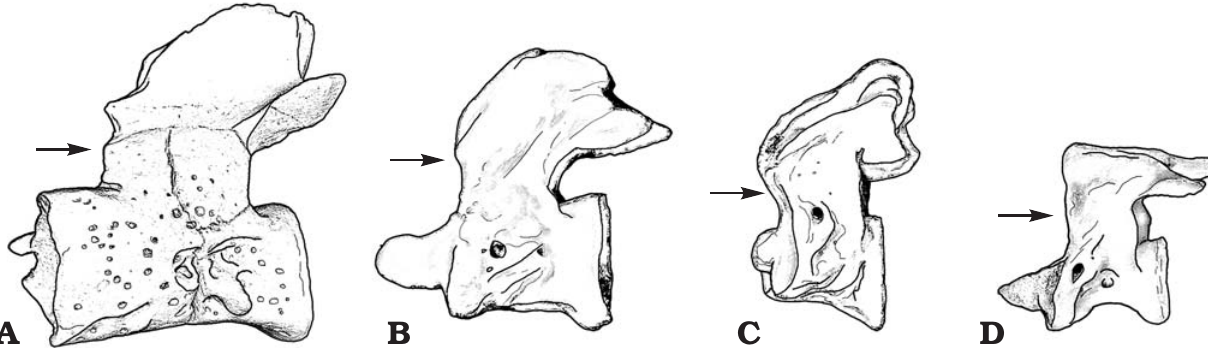
Fig. 5. Drawings of atlases of stem (A) and extant crown (B–D) salamanders in lateral views. A . Kulgeriherpeton ultimum gen. et sp. nov. B . Cryptobranchus . C . Amphiuma . D . Hynobius . Note the antero-posteriorly short neural arch with its anterior border situated far behind the level of the anterior cotyles in stem salamanders (A) and long neural arch with its anterior border is situated at the level of the anterior cotyles in crown salamanders (B–D). Arrows show the anterior border of the neural arch. Not to